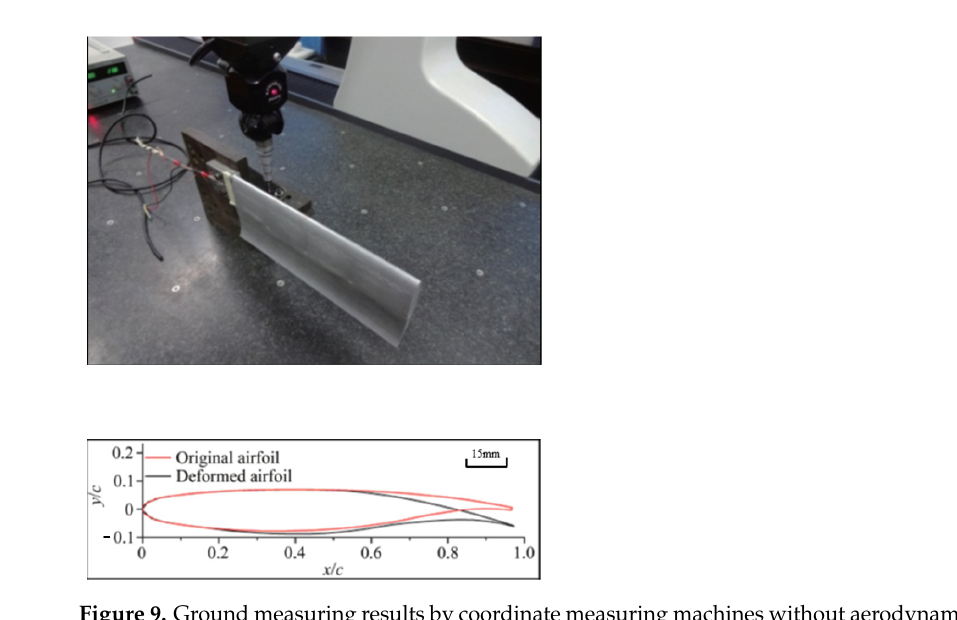
Figure 10. Model test section. PSP, pressure-sensitive paint.